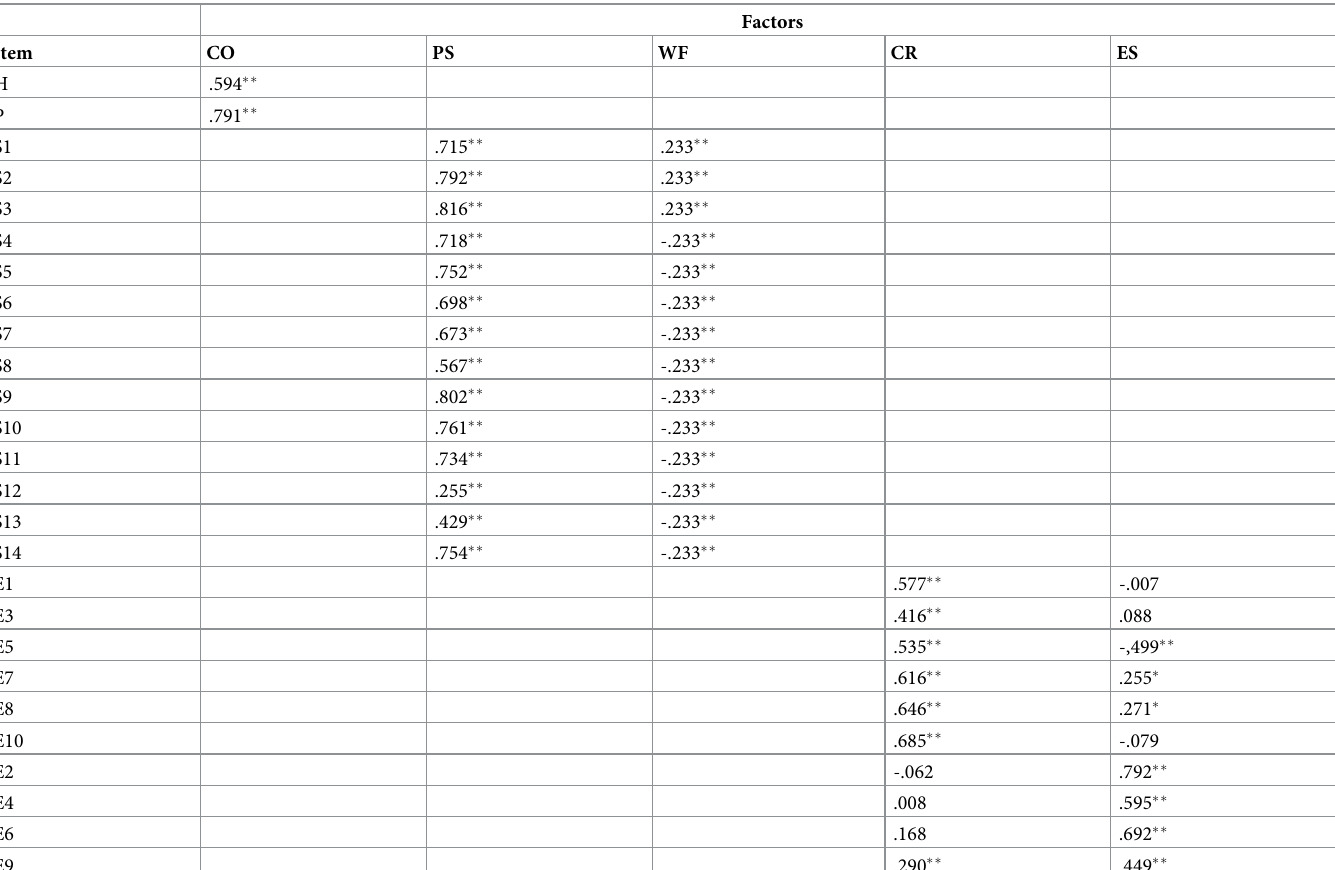
Table 1. Item factor loadings for the estimated SEM